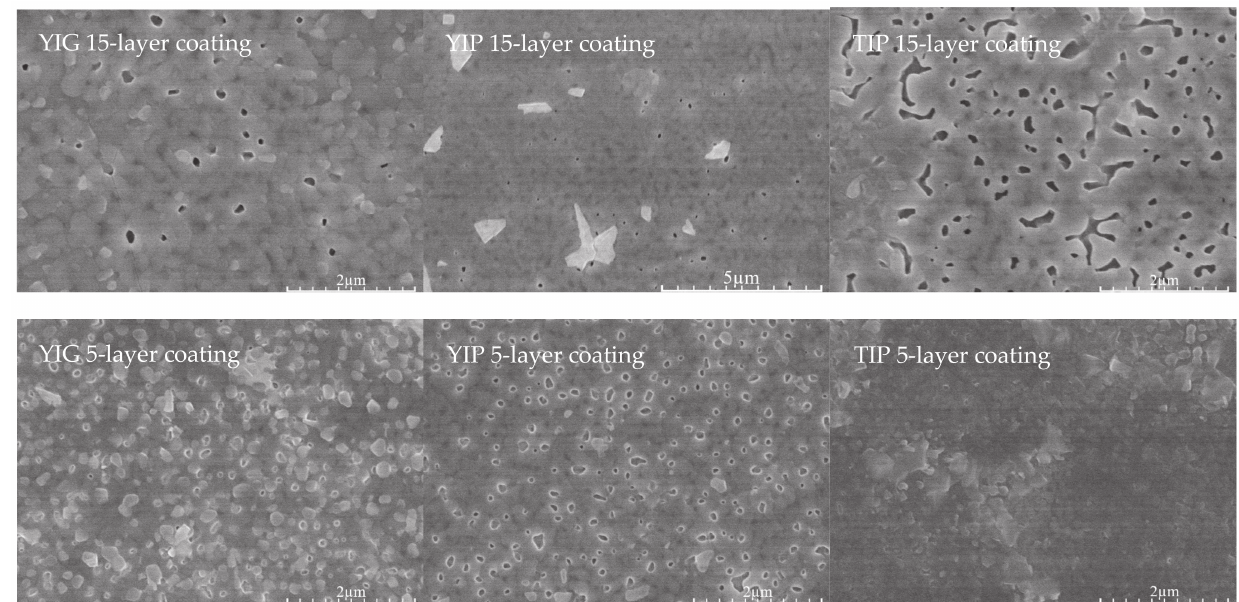
Figure 4. SEM micrographs of the surfaces of sol-gel derived YIG, YIP, and TIP